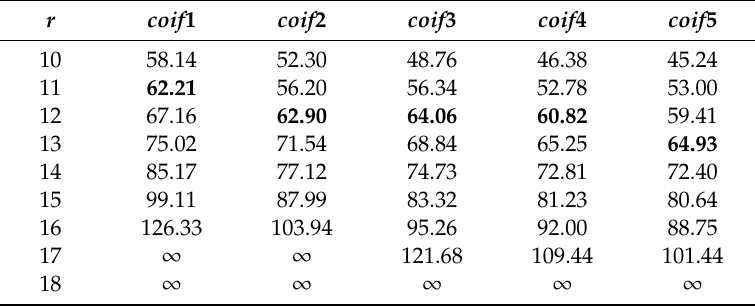
Table 27. Experimental results ( PSNR , dB) of 3D tomographic 12-bit image “Trufi_COR” DWT by using bit-width r of coiflets filters coe ffi cients.